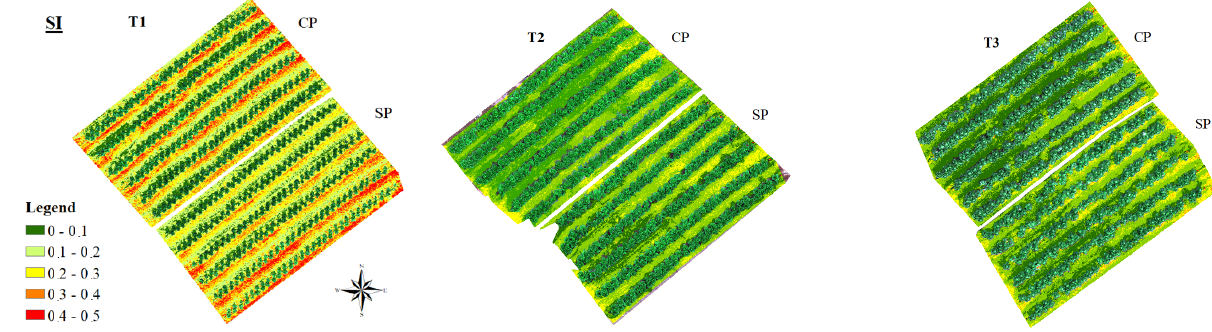
Figure 4. SI maps applied only to bare soil for T1, T2, and T3.